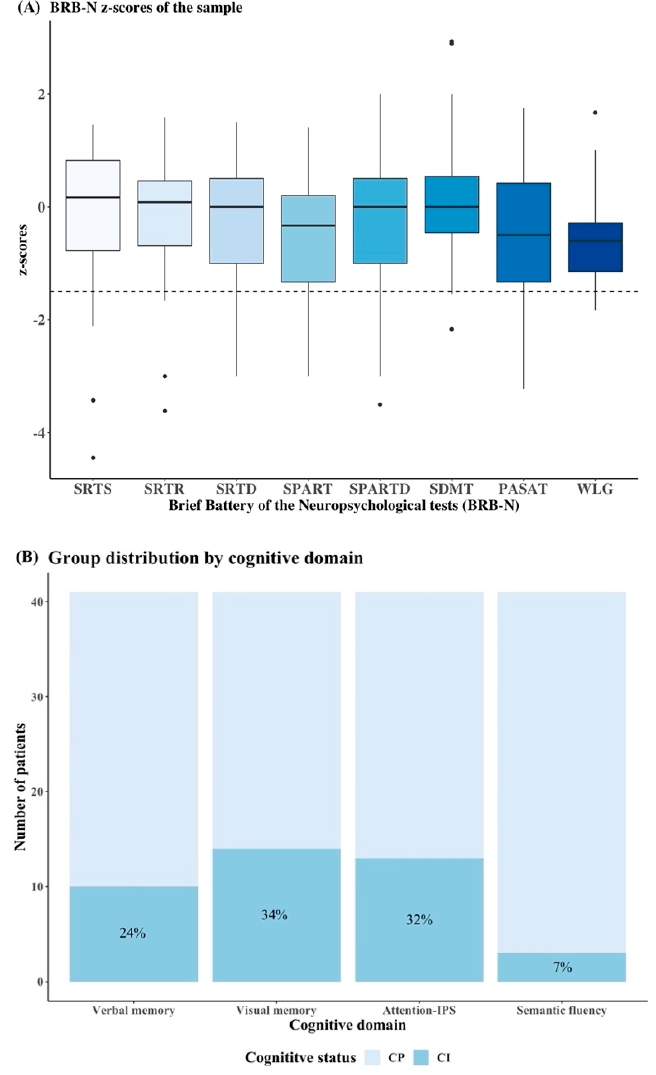
Figure 1. Cognitive performance in NMOSD patients. ( A ) Box plots represent the cognitive z-score distribution for each test from the BRB-N in the entire cohort; the x -axis depicts the name of each cognitive test and the y -axis the z-score for each test. The dotted black horizontal line represents − 1.5 SDs of the norm. ( B ) The histograms show the proportions of patients with CP and CI in each cognitive domain. The x -axis shows the names of cognitive domains and the y -axis the number of patients for each domain. The total number of patients in each cognitive domain was 41. Both figures were fitted using R version 3.5.2 (R Foundation for Statistical Computing, Vienna, Austria). SRTS: Selective Reminding Test Long-Term Storage; SRTR: Selective Reminding Test Consistent Long-Term Retrieval; SRTD: Selective Reminding Test Total Delay; SPART: Spatial Recall Test; SPARTD: Spatial Recall Test Delay; SDMT: Symbol Digit Modalities Test; PASAT: Paced Auditory Serial Addition Task; WLG: Word List